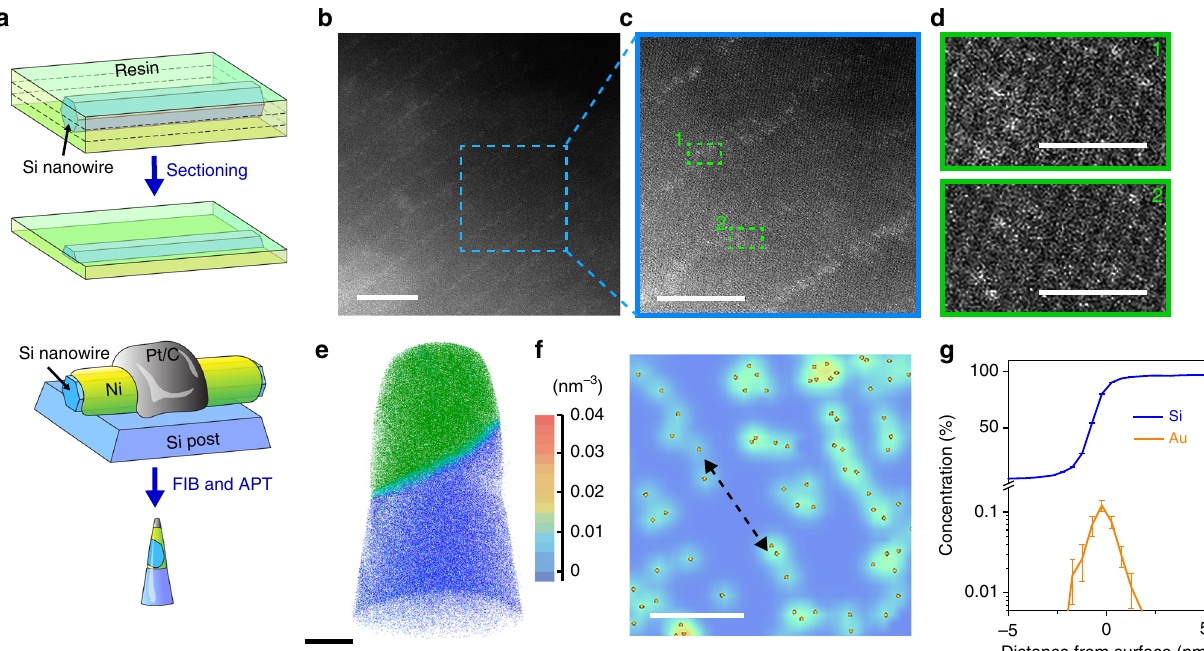
Fig. 2 Atomic Au lines form over Si nanowire sidewalls. a Schematics of microtomed samples for STEM and FIB-milled samples for APT characterizations, showing the regions of interest. b An aberration-corrected STEM image of ordered line patterns over Si surfaces. Scale bar, 10 nm. c A high-resolution STEM image for a zoom-in view from b (region labeled with blue dashed box). Scale bar, 5 nm. d Isolated gold atoms images highlighted in the line regions from c (marked by two green dashed boxes). Scale bar, 1 nm. e APT analysis displays the 3D atom-by-atom chemical reconstruction of a nanowire surface region. Atomic positions are represented by blue (Si, 2.5% shown), cyan (O, 100% shown), and green (Ni, 10% shown) dots. Scale bar, 20 nm. f A 2D color-coded map of gold atomic density exhibits a chain-like arrangement, indicated by a black dashed arrow. Orange spheres represent gold atoms. Scale bar, 10 nm. g Proximity histogram concentration pro fi le of Si and Au in the direction normal to the Si